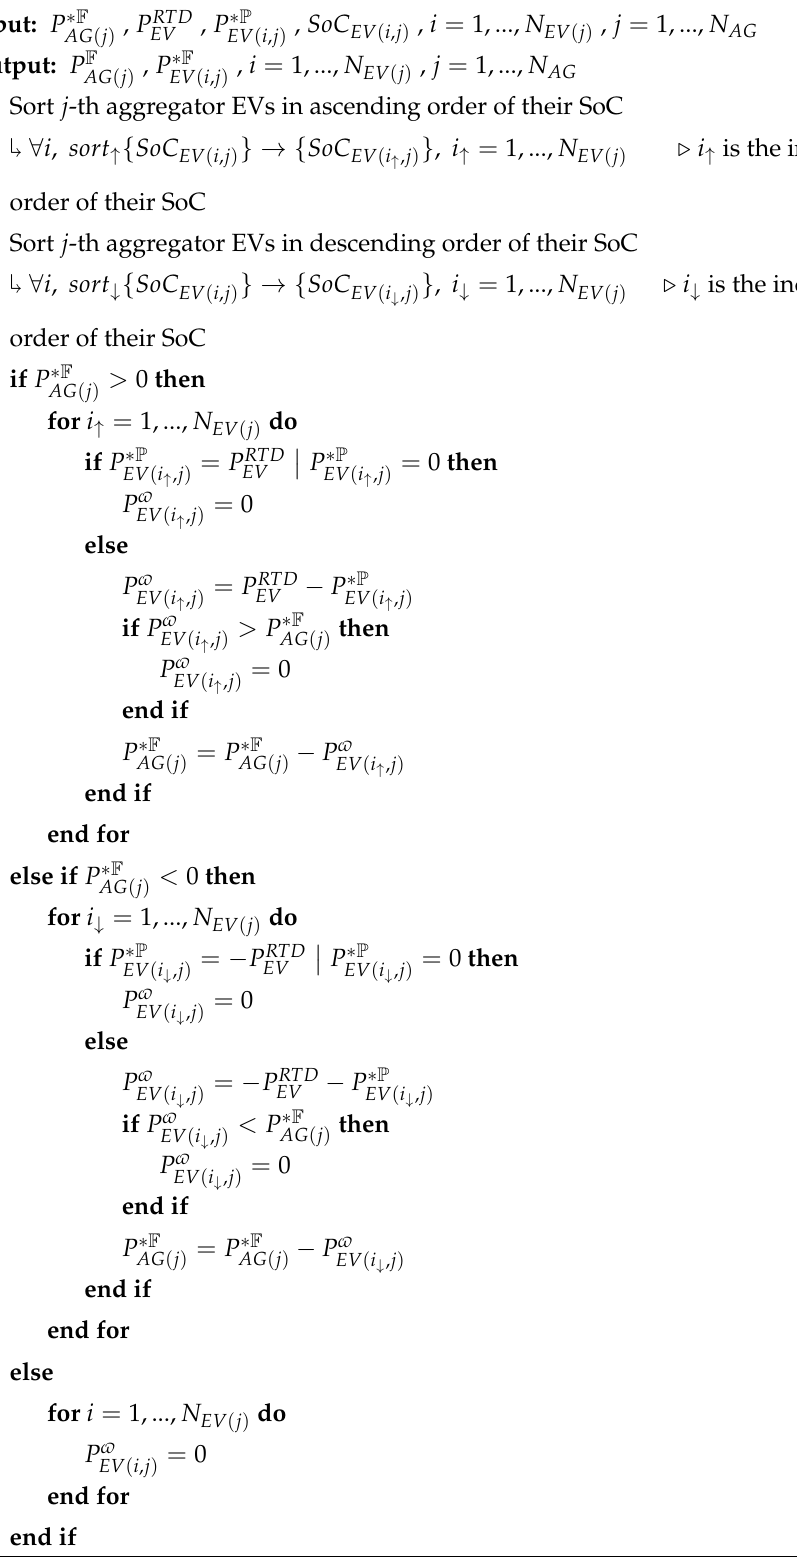
Algorithm 3 Water Filling Algorithm for